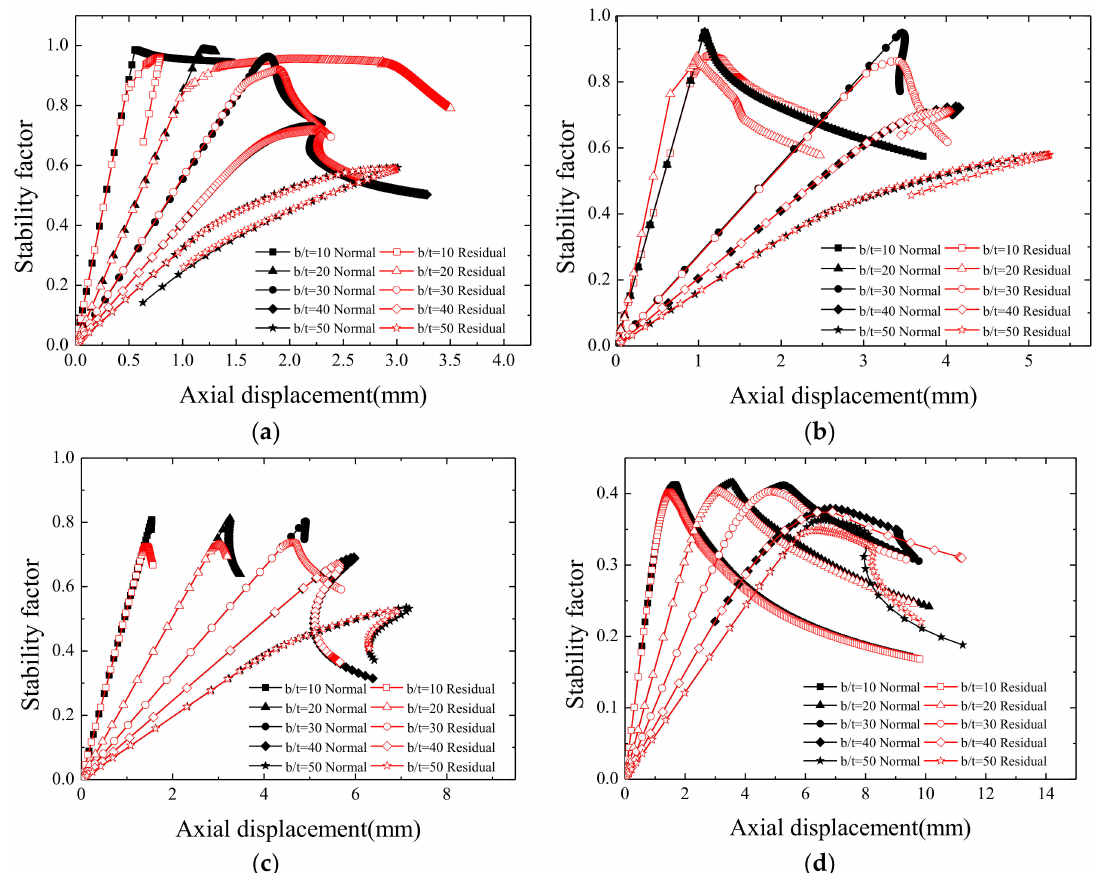
Figure 19. Load axial displacement curves with di ff erent slenderness and width-thickness ratios. ( a ) λ = 15, ( b ) λ = 30, ( c ) λ = 50, and ( d ) λ =